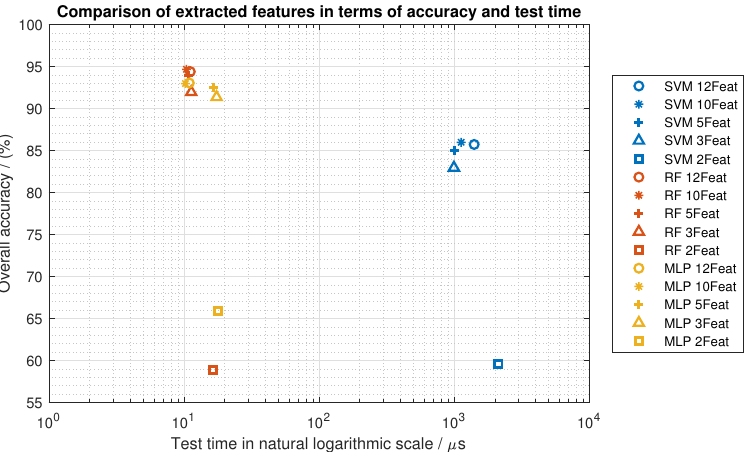
Figure 5. Performance comparison of three ML models (SVM, MLP, and RF) using different extracted features at training and test data collected for the same